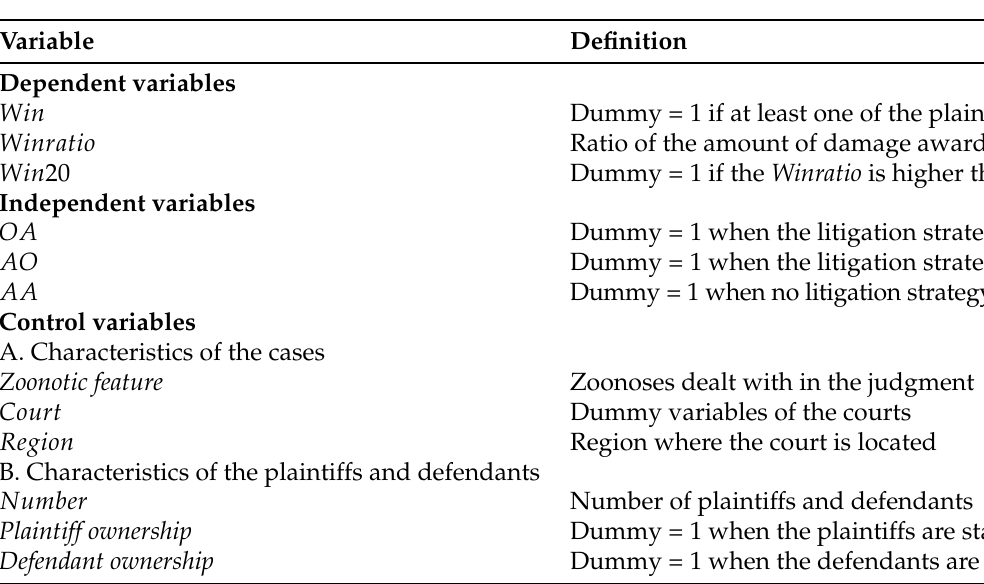
Table 2. Variables and their